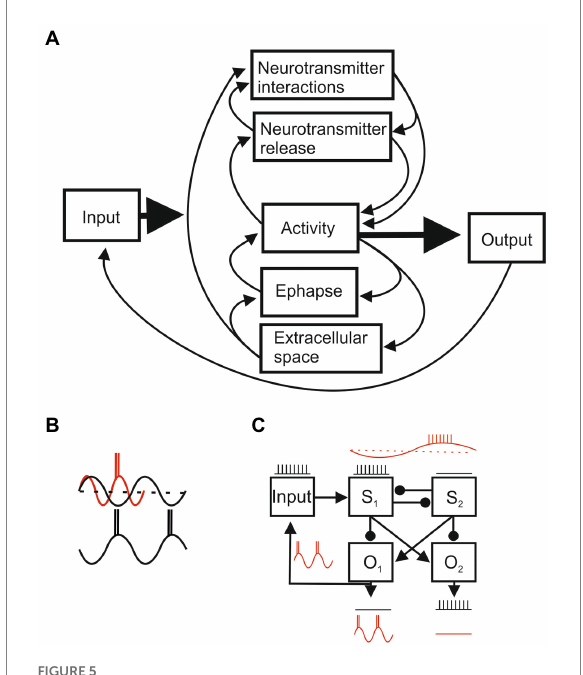
FIGURE 5 (A) Circular interactions between system components. Each component will have sub-systems with specific parameters that determine their states (e.g., connectivity, ion channel conductances, and synaptic strengths), initial and boundary conditions, and varying dynamic variables (e.g., membrane potential and activation or inactivation state of ion channels) that determine their outputs. The parameters of each of component can be precisely measured in reduced and quiescent preparations, but when the intact system is activated parameter values will change through inputs from other components and from external and re-afferent (feedback) inputs. Function arises from self-organized dynamic system activity that reflects the spatial arrangement of components and various temporal aspects (e.g., neurotransmitter signaling will be fast at ionotropic receptors and slower at metabotropic receptors; transmitter interactions and changes in the extracellular space will be slower still). Short and long-term plasticity can alter component properties and connections by changing initial and boundary conditions. A localized change could affect the whole